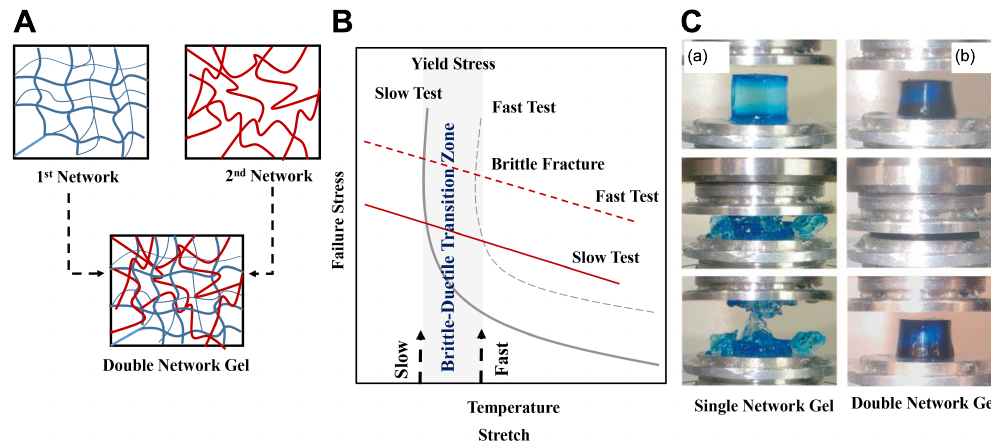
Figure 11. Hydrogel network formation and mechanical strength testing. ( A ) A typical example of double-network (DN) hydrogel formation. ( B ) Representation of the transition from brittle to ductile structures in a polymer network. Adapted with permission from [4]. Copyright 2009, John Wiley & Sons, Inc. ( C ) Compression of ( a ) single-network gel, and ( b ) DN gel illustrating how DN gel can sustain high compression. Reproduced with permission from [91]. Copyright 2003, John Wiley & Sons,